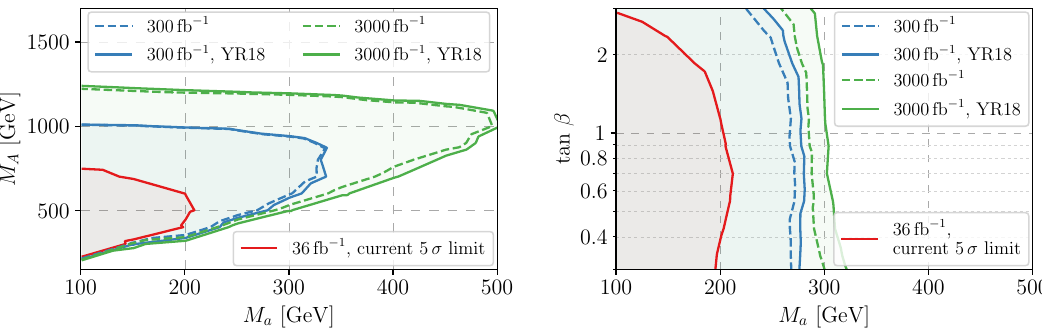
Figure 10 . Current 5 (cid:27) exclusion limits for the 2HDM+PS (in red) and projected ones for the high-luminosity LHC (in blue and green) for mono- Z searches in the in the M a { M A -plane (left) and M a {tan (cid:12) -plane (right). The 2HDM+S limits are nearly identical and therefore not shown. The dashed lines correspond to a scenario without any improvement in the systematic uncertainties, whereas the solid lines assume a reduction by 50 %, called YR18 scenario. For the other parameters, the numerical values used are identical to (cid:12)gure